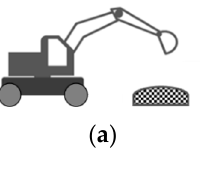
Figure 3. Engine energy flow.